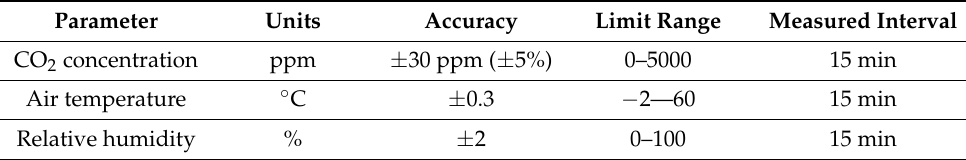
Table 3. Case Study Buildings (B—basement, G—ground floor, B + G + 2—basement + ground floor + 2 stories). Sample of Buildings